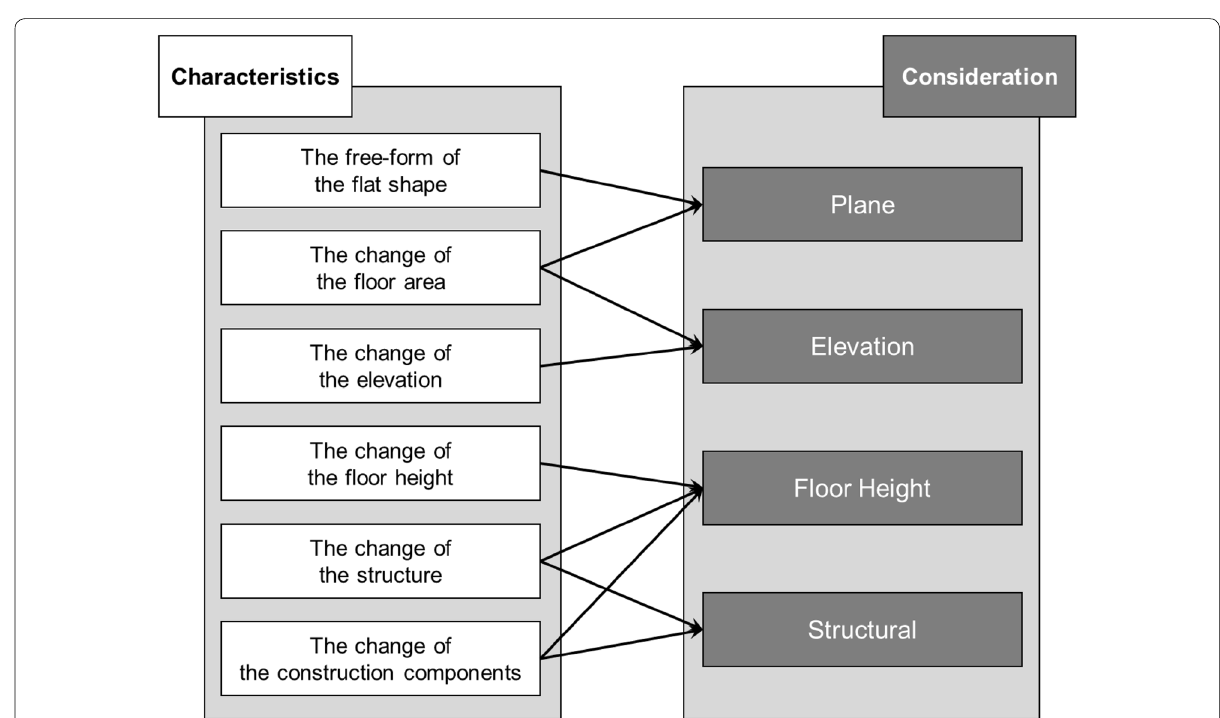
Fig. 2 Selection process of